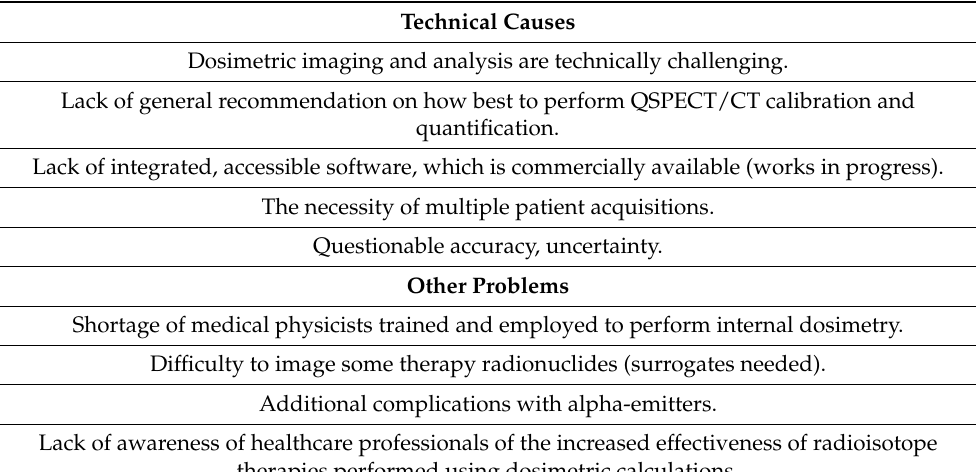
Table 3. Main reasons for the difficulties in clinical implementation of dosimetric imaging and